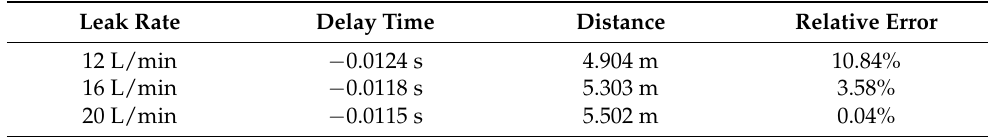
Table 3. Localization distance and localization relative